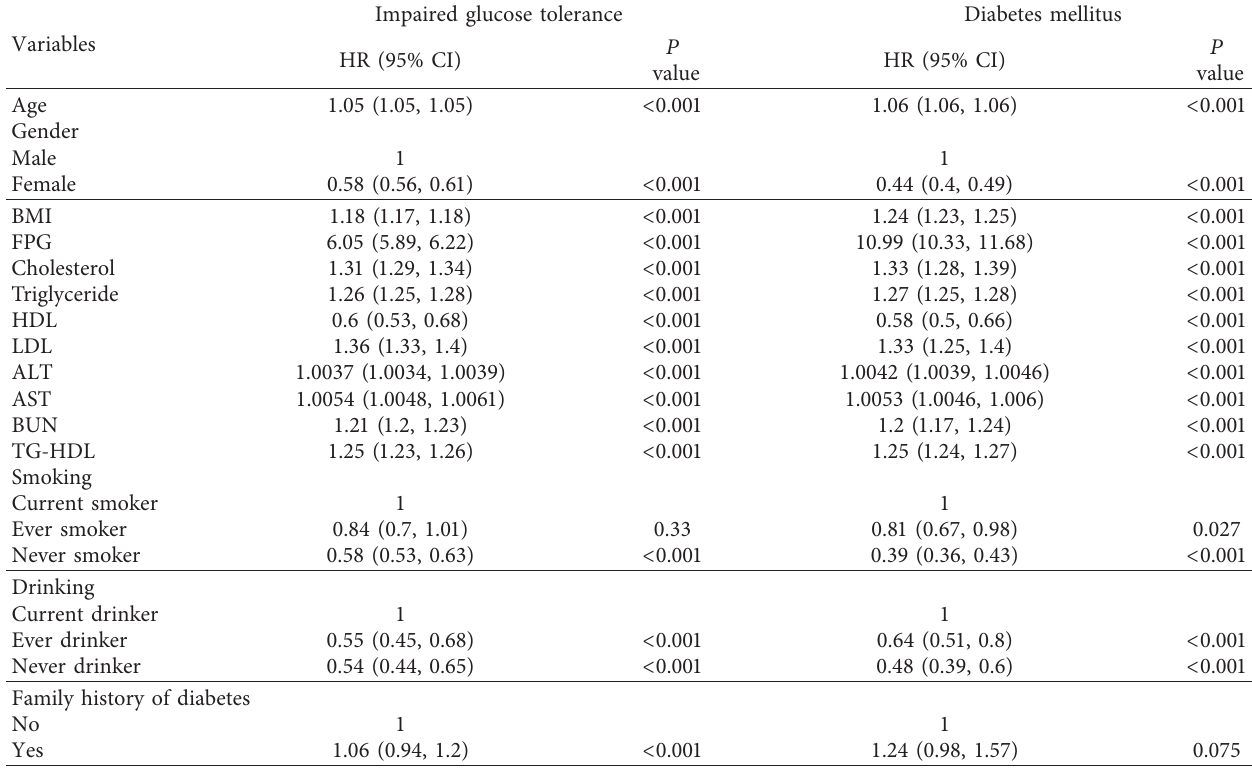
Table 2: Univariate analysis for impaired glucose tolerance and diabetes mellitus.